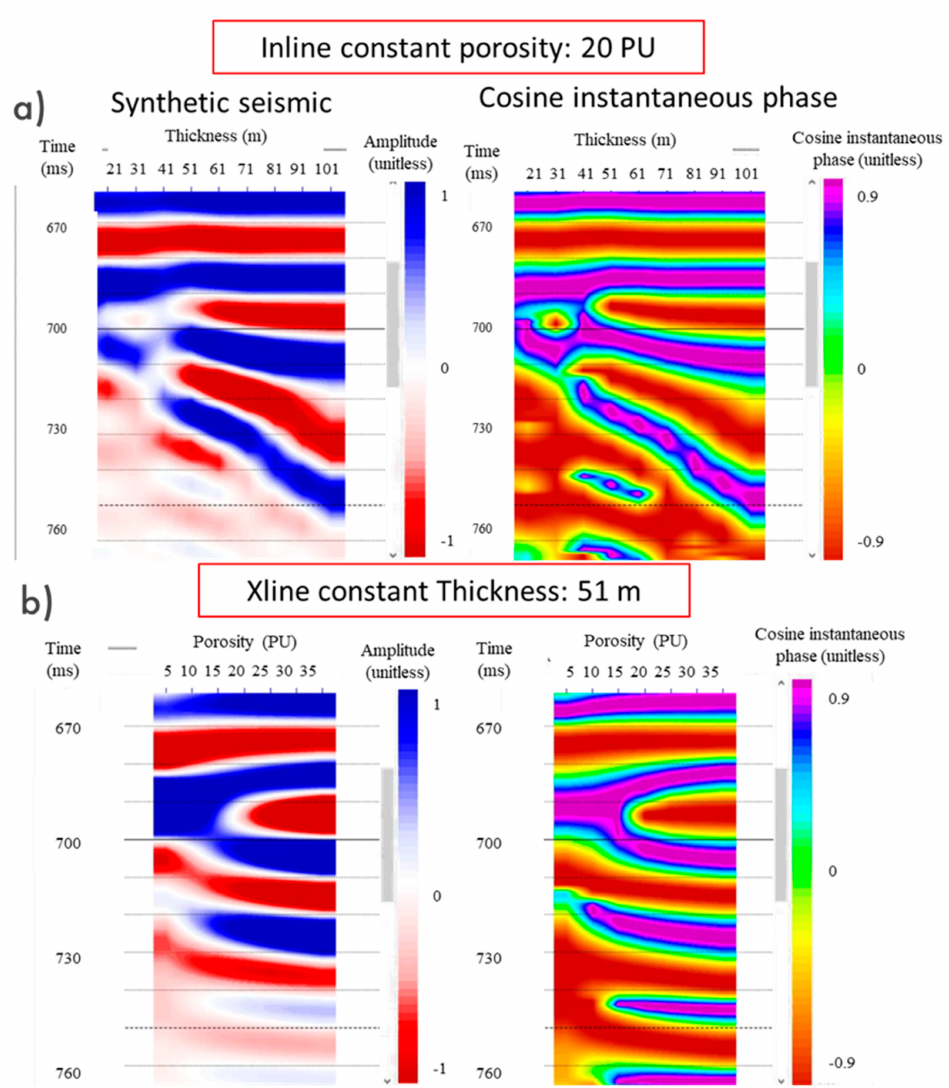
Figure 6. ( a ) Left: inline of synthetic seismic data that represents constant porosity of 20 PU; crossline variations represent thickness changes. Right: cosine of the phase of the inline on the left. ( b ) Left: crossline of synthetic seismic data that represents a constant thickness of 51 m; inline variations represent porosity changes. Right: cosine of the instantaneous phase of the crossline on the left. Polarity: an increase in amplitude corresponds to an increase in acoustic